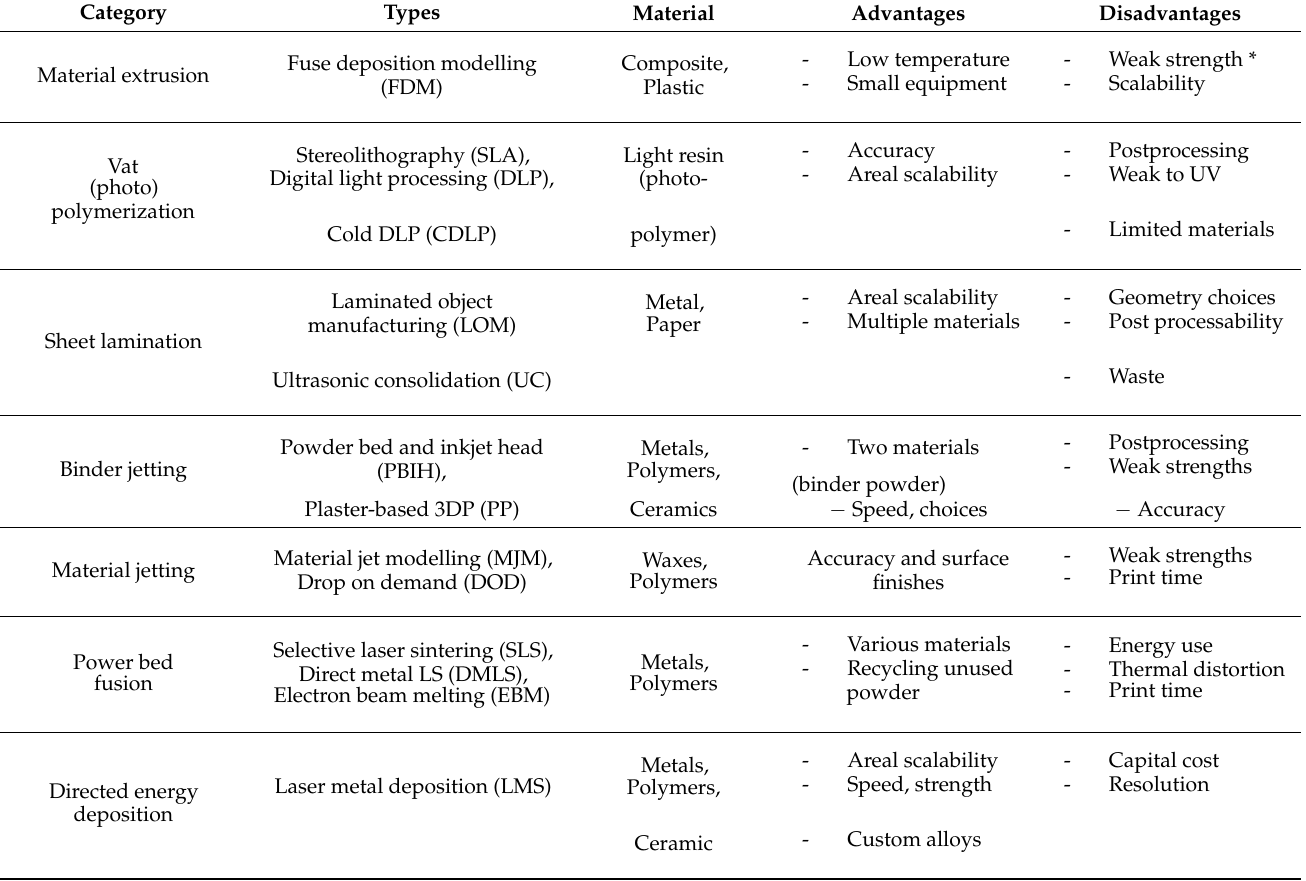
Table 7. Summary of AM methods and their characteristics